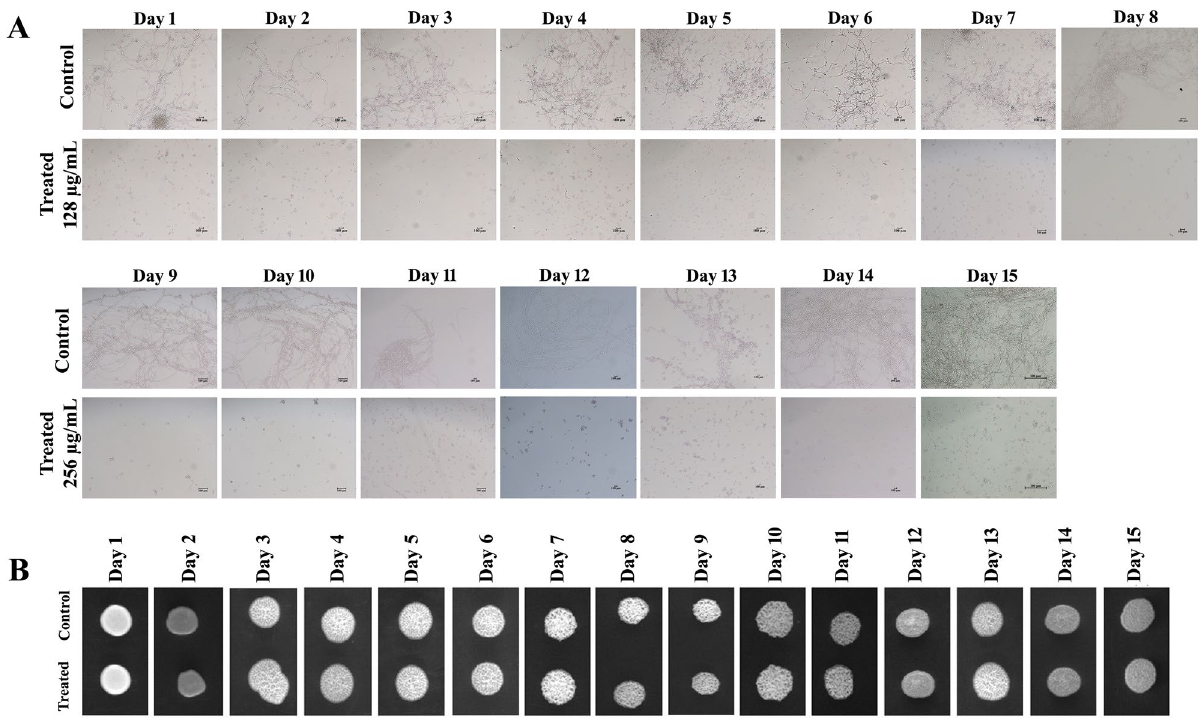
Figure 14. Serial passage experiment by repeated exposure of catechol to C. albicans cells on both YEPD and spider liquid media. ( A ) Light graphs were displayed the potential of catechol in inhibiting the yeast to hyphae transition even after serial 15 passages (magnification ×200, scale bar 100 μm). ( B ) Spot assay revealed non- impairment of C. albicans metabolic growth in presence and absence of catechol even after 15 serial